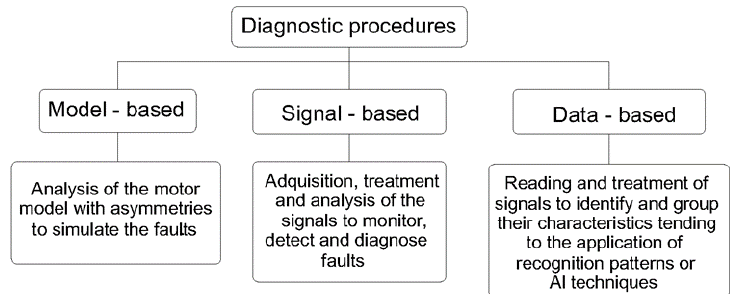
Figure 3. Methods of analysis using Motor Current Signature Analysis (MCSA), as shown in